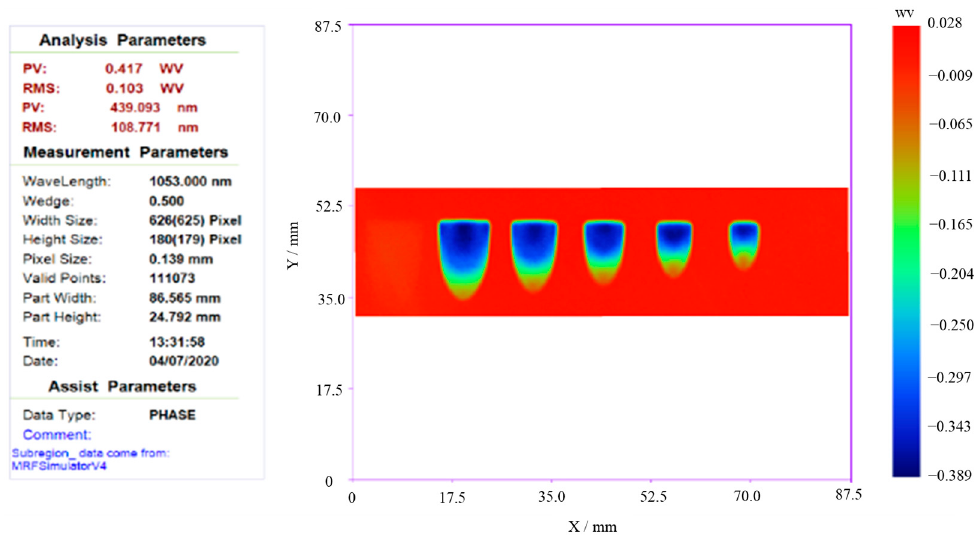
Figure 13. MRF spots with di ff erent scales.